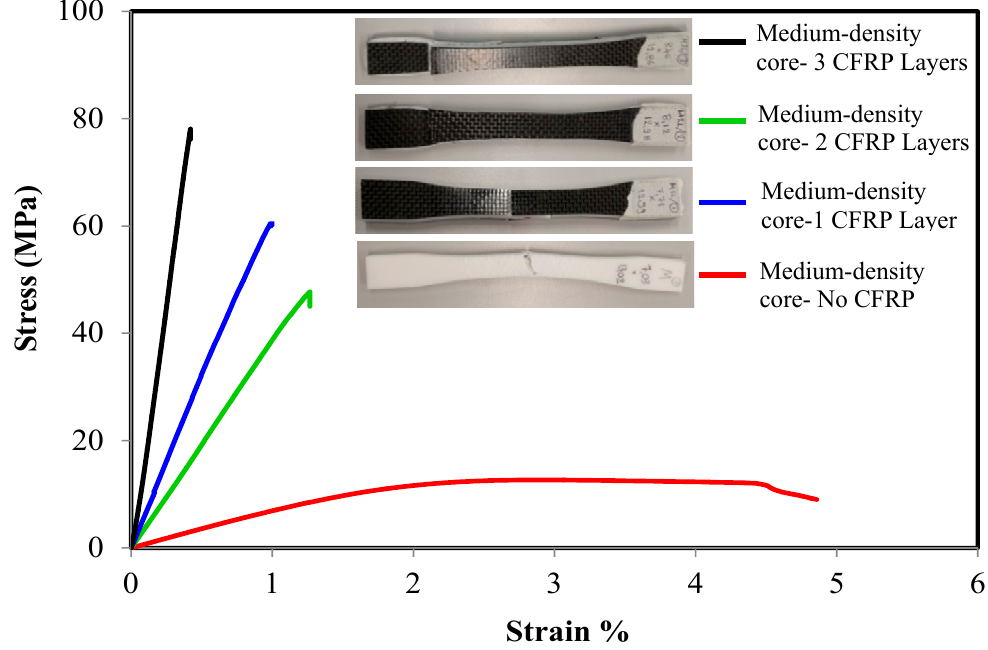
Figure 5. Typical tensile stress-strain response of medium-density core CFRP/ABS/CFRP composite samples.